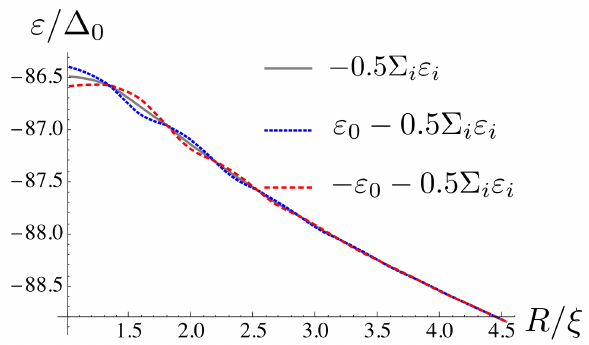
Figure 8: The Majorana energy oscillations as a function of the inter-vortex separa- tion on top of the ground state energy shift (the vortex-vortex repulsion) from Eq. (24) when including the lowest 150 states on a finite slab with Dirichlet boundary